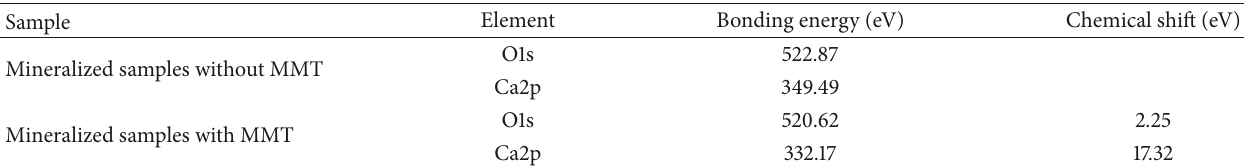
Figure 4: TG spectra of mineralized samples with MMT and without MMT. Table 2: Binding energy data for mineralized